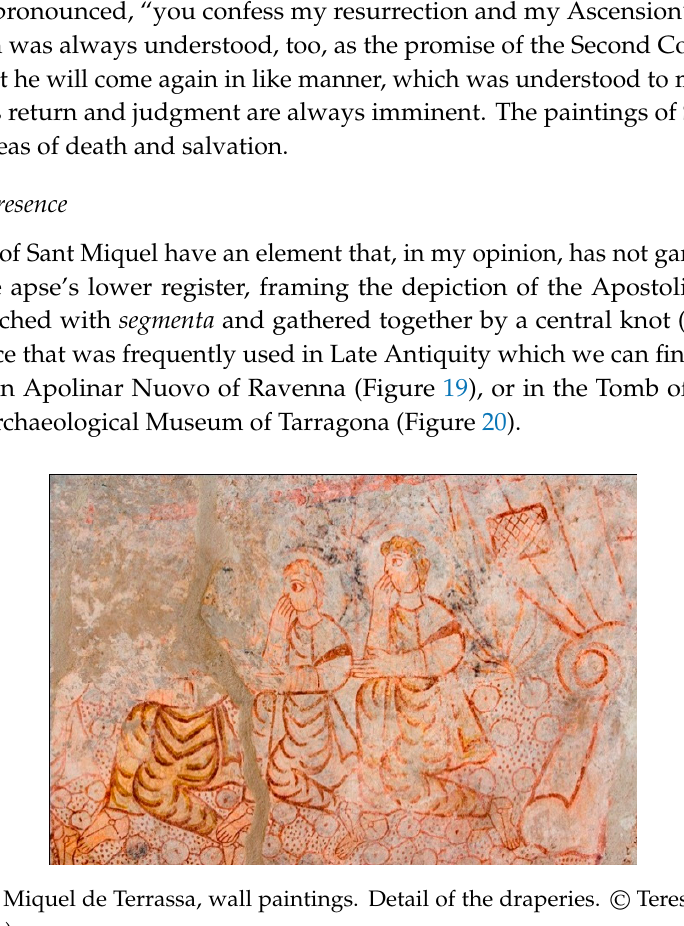
Figure 19. Mosaic of Sant’Apollinare in Classe, Ravenna (Italy). Sixth century. Abraham, Abel, and Melchisedec © Author: Sailko.